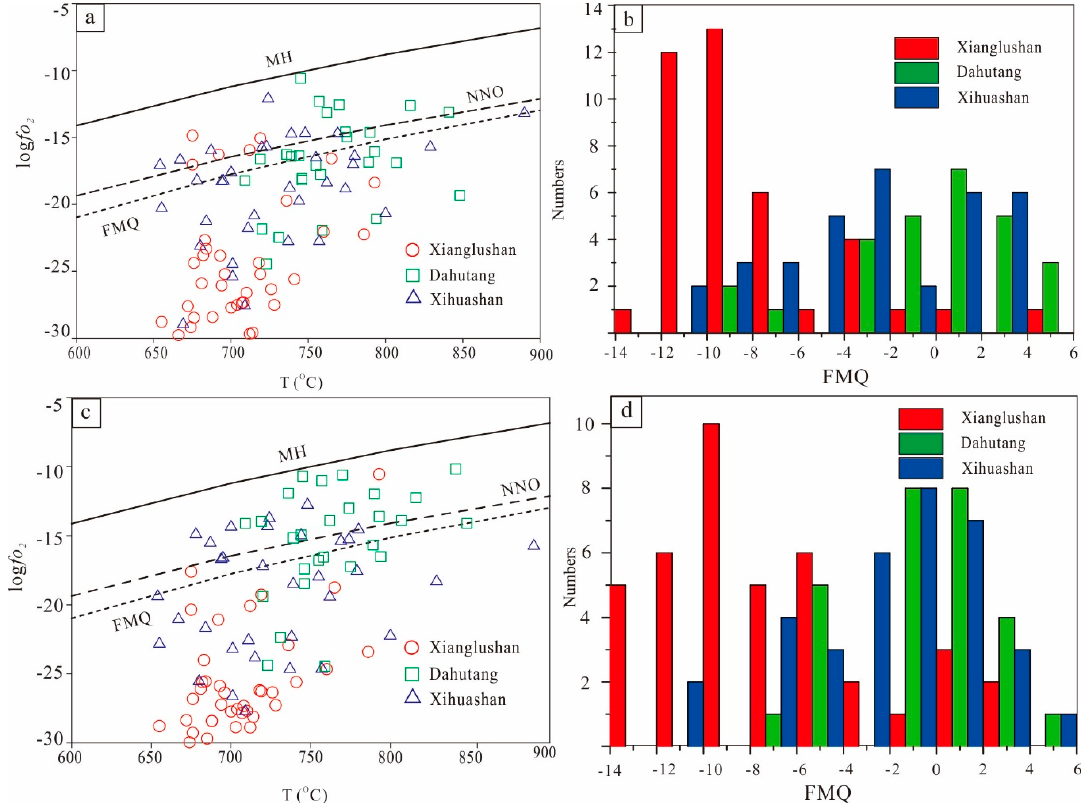
Figure 7. log f O 2 -related binary diagrams of zircon grains from the Xianglushan, Dhutang and Xihuashan granites. ( a ) log f O 2 vs. temp diagram, where log f O 2 value was calculated with the method of Trail et al. [34], and Ce N * with the La - Pr interpolation method; ( b ) Histogram of oxygen fugacity; ( c ) log f O 2 vs. temp diagram, where log f O 2 value was calculated with the method of Trail et al. [34], and Ce N * with the Sm - Nd fitting method; ( d ) Histogram of oxygen fugacity. Data are listed in Table A1.